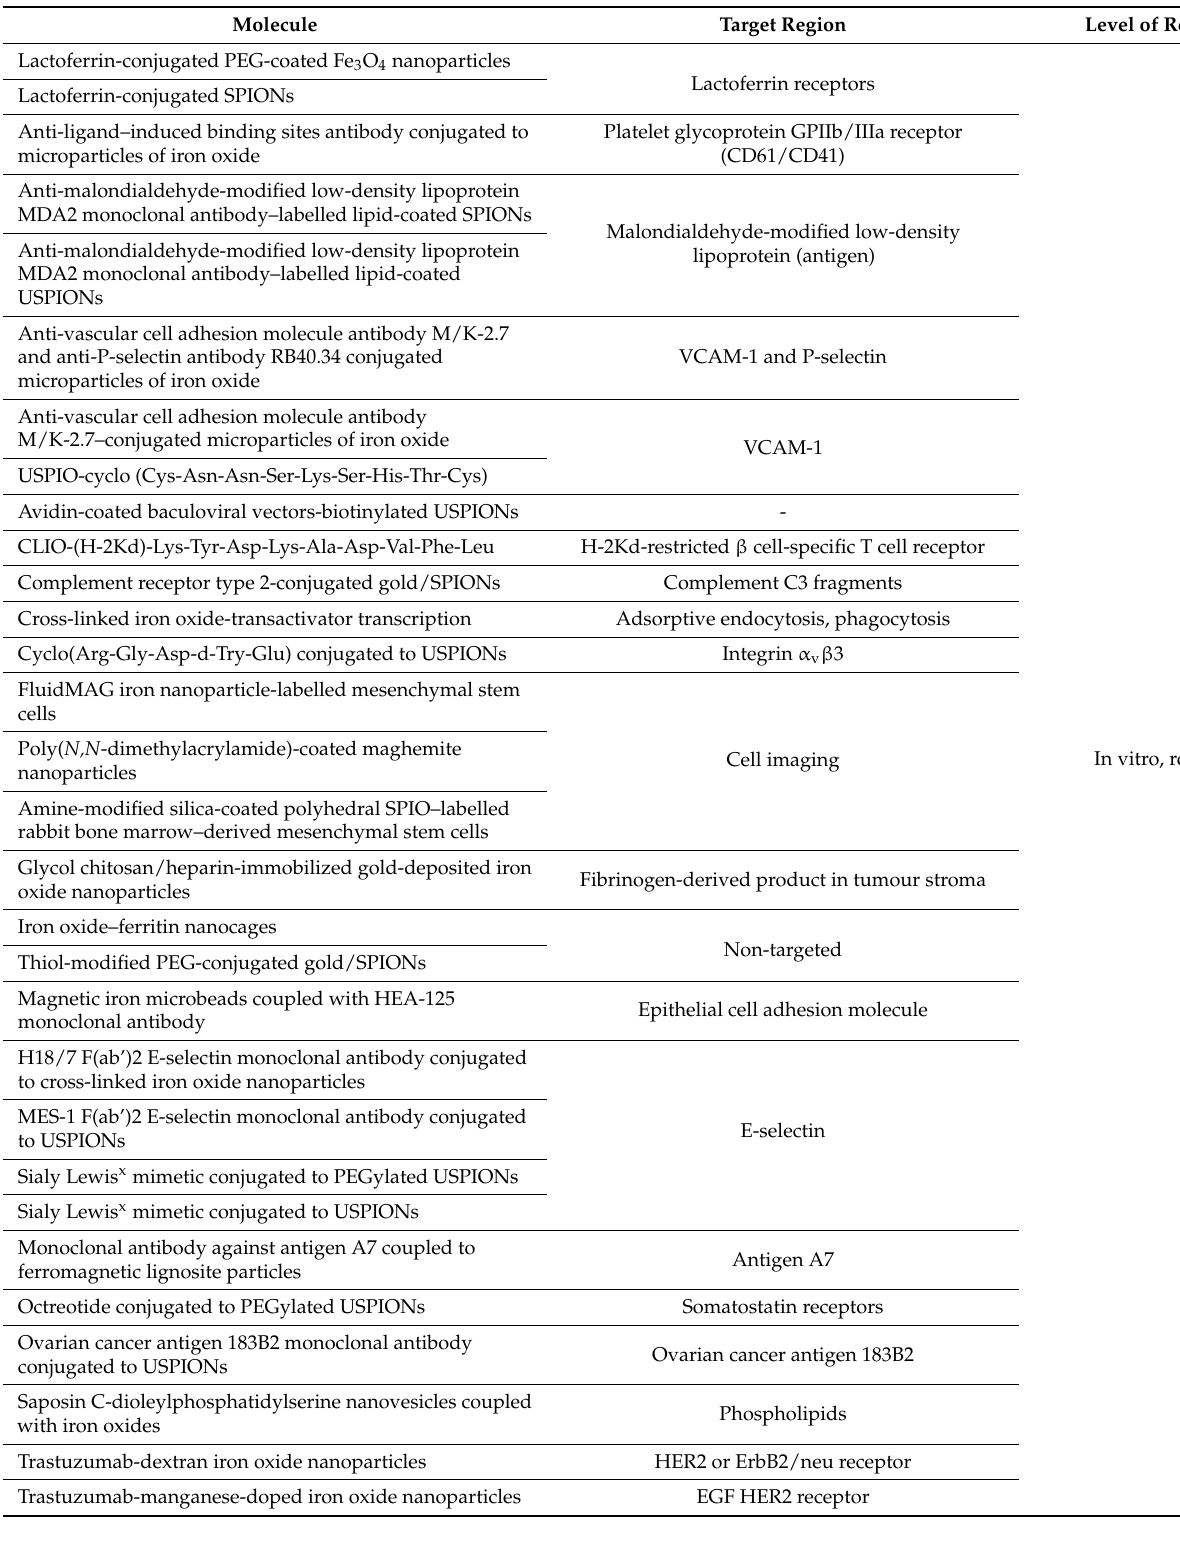
Table 1. Iron oxide-based MRI contrast agents, as described in MICAD [15], with Fe 3 O 4 /SPIONs/USPIONs/iron oxide nanoparticles as a source of